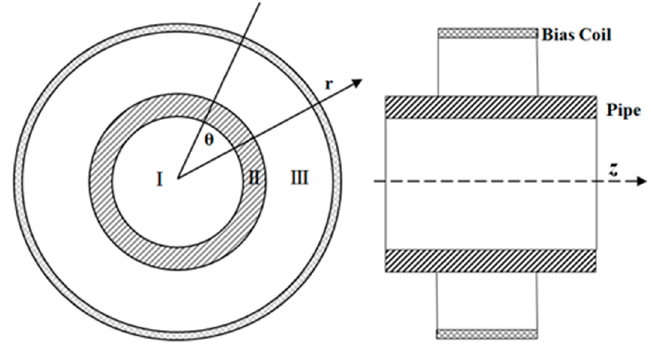
Figure 3. Layout of the model at the receiving position.